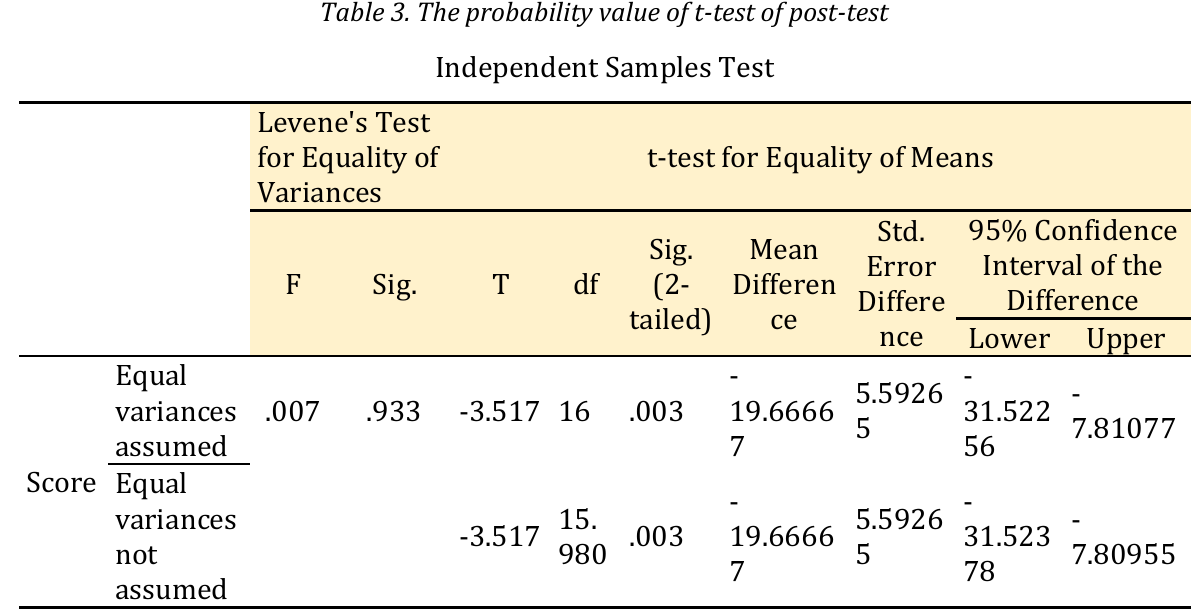
Table 3. The probability value of t-test of